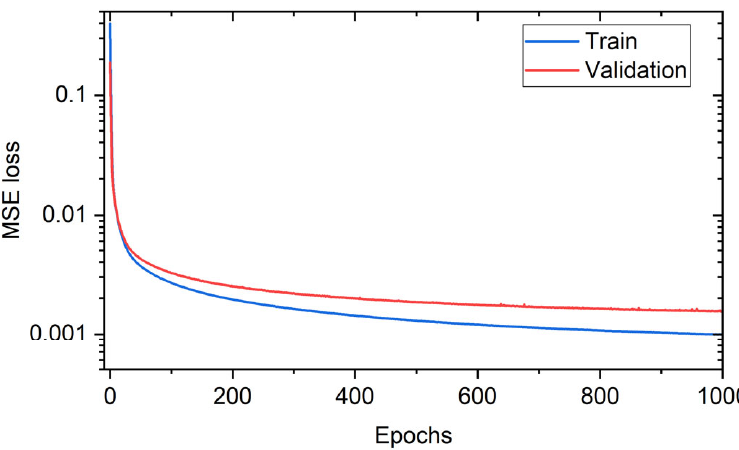
Figure 7. Learning curve of the feed ‐ forward neural network.